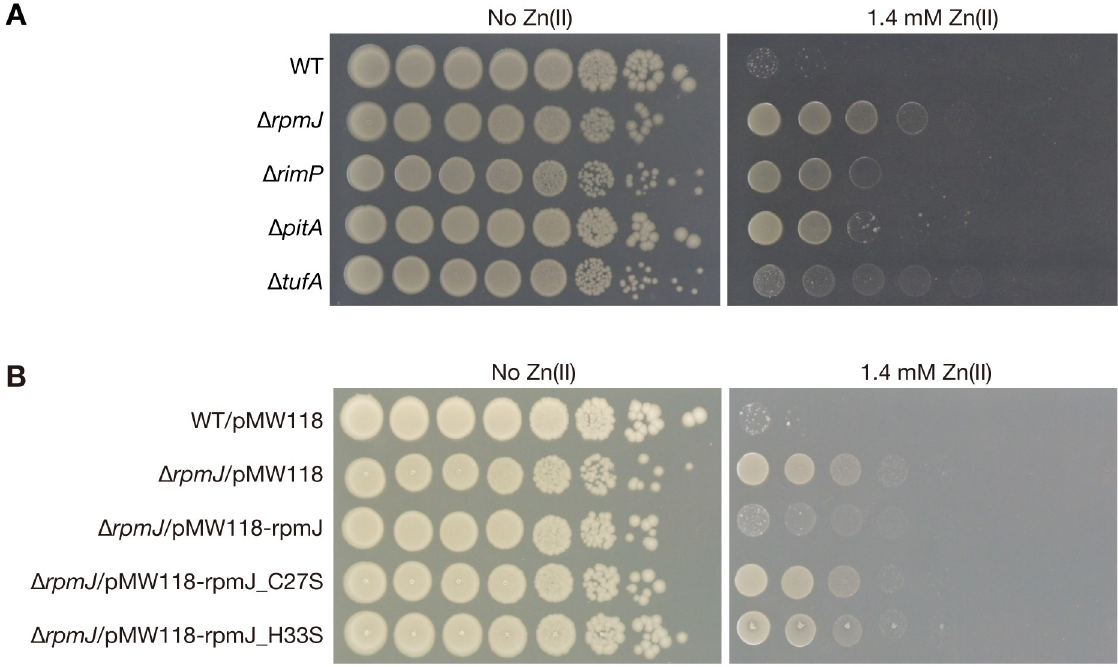
Fig 1. The rpmJ mutant exhibits zinc resistance. A. Overnight cultures of the wild-type strain and knockout mutants ( Δ rpmJ , Δ rimP , Δ pitA , and Δ tufA ) were serially diluted 10-fold, spotted onto LB agar plates with or without 1.4 mM Zn(II), and incubated overnight at 37˚C. B. Overnight cultures of the wild-type strain transformed with an empty vector (WT/pMW118), the rpmJ mutants transformed with an empty vector ( Δ rpmJ /pMW118), a plasmid carrying intact rpmJ gene ( Δ rpmJ /pMW118-rpmJ), and plasmids carrying mutated rpmJ genes ( Δ rpmJ / pMW118-rpmJ_C27S, Δ rpmJ /pMW118-rpmJ_H33S) were serially diluted 10-fold, spotted onto LB agar plates with or without 1.4 mM Zn (II), added 1 mM IPTG, and incubated overnight at 37˚C.